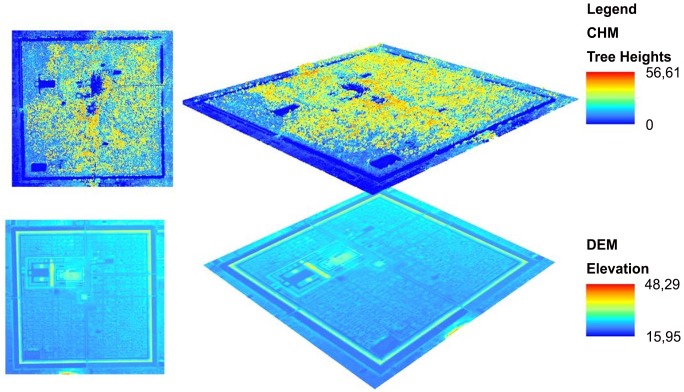
The Digital Elevation Model and the Canopy Height Model of the study area.